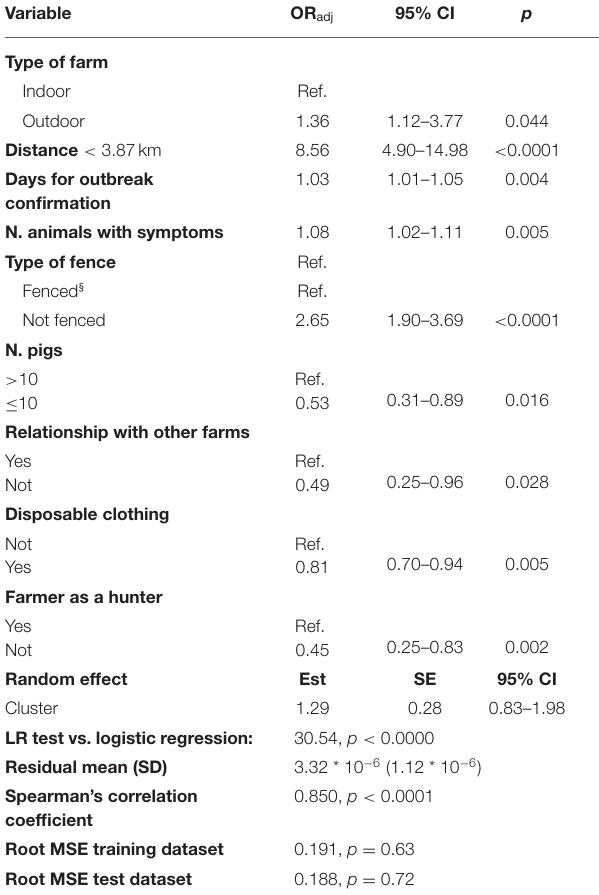
TABLE 5 | Logistic mixed model results using fast (1) or normal (0) outbreaks as outcome, with a time cut-off from primary case < 20 days for categories definition, based on uniform-kernel-smoothed function.